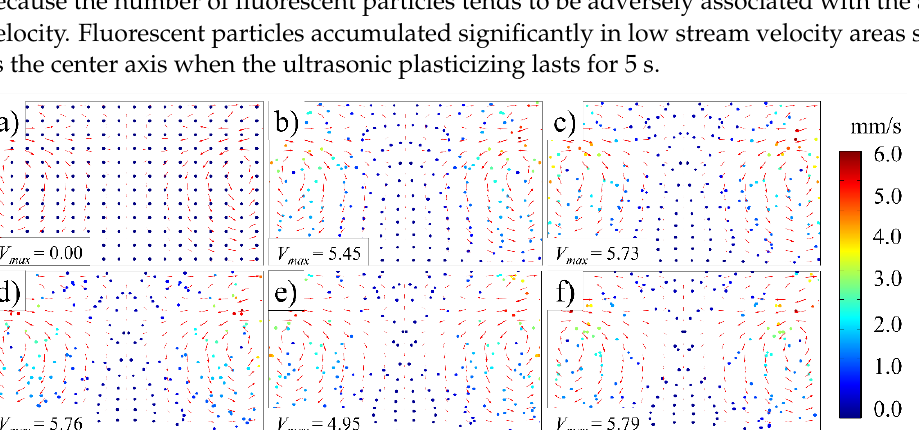
Figure 4. Forces on fluorescent particles (ultrasonic frequency, 20 kHz; ultrasonic amplitude, 80 μm). ( a ) Seeding the fluorescent particles. ( b ) Stokes drag force distribution. ( c ) Acoustic radiation force distribution.